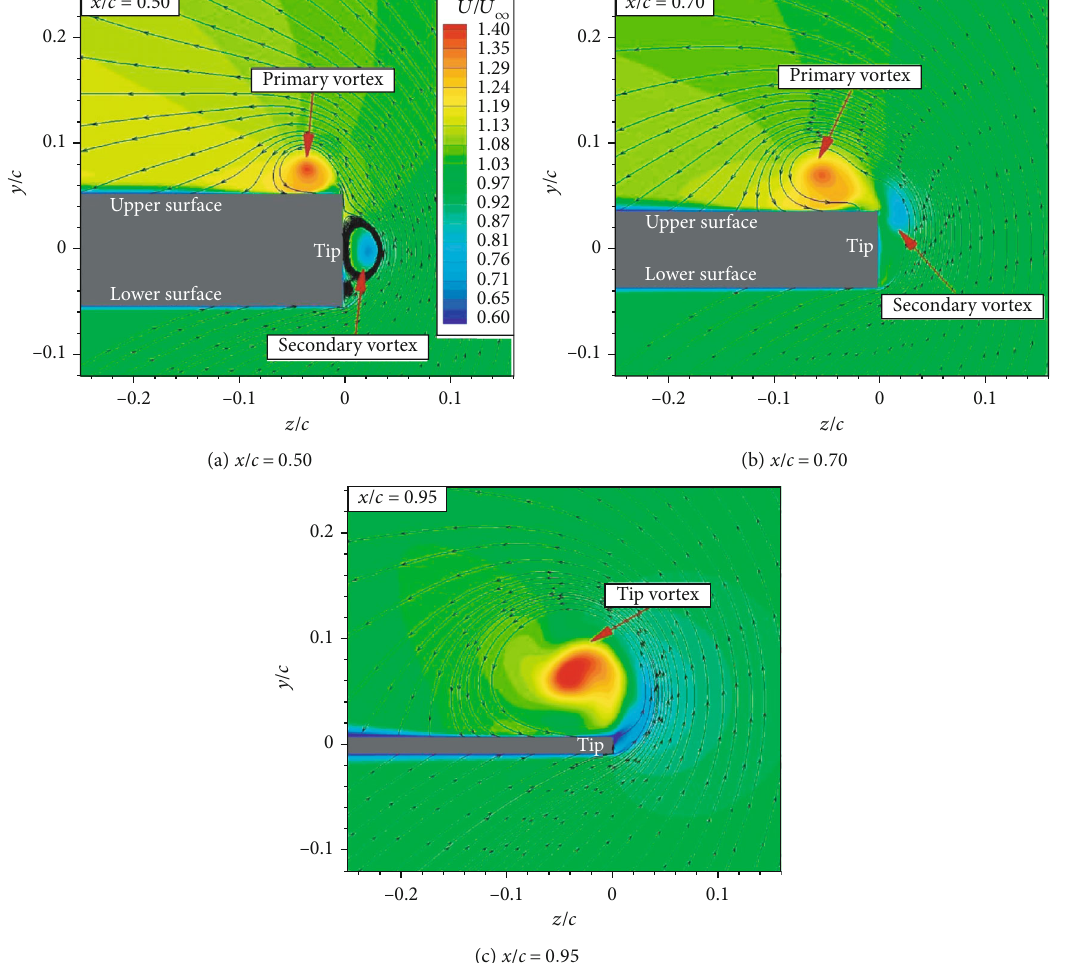
Figure 7: The evolution of the wingtip